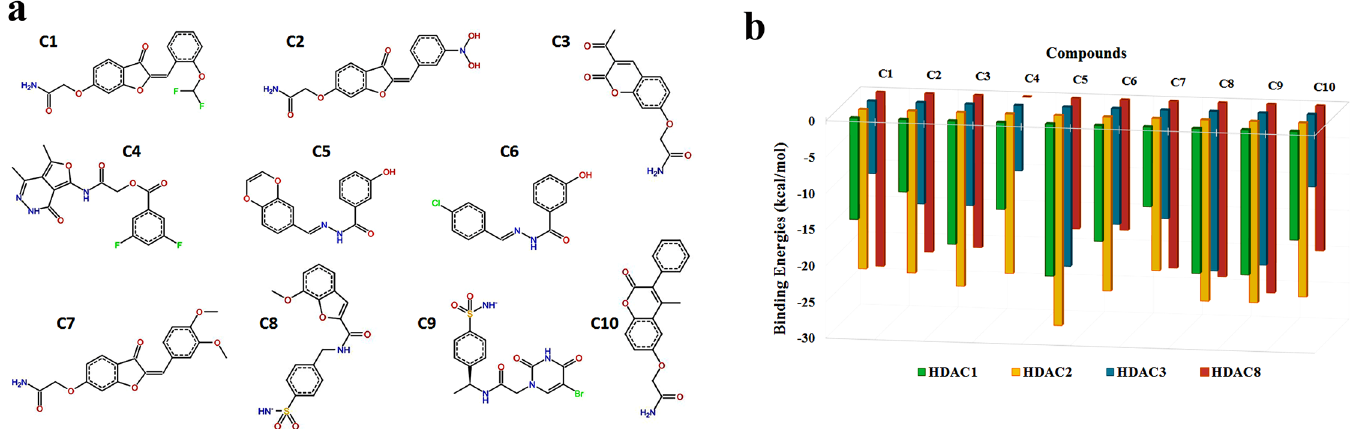
Fig 3. 2D structures and binding energies of compounds C1-C10. (a) 2D structures (b) Binding energy overview.